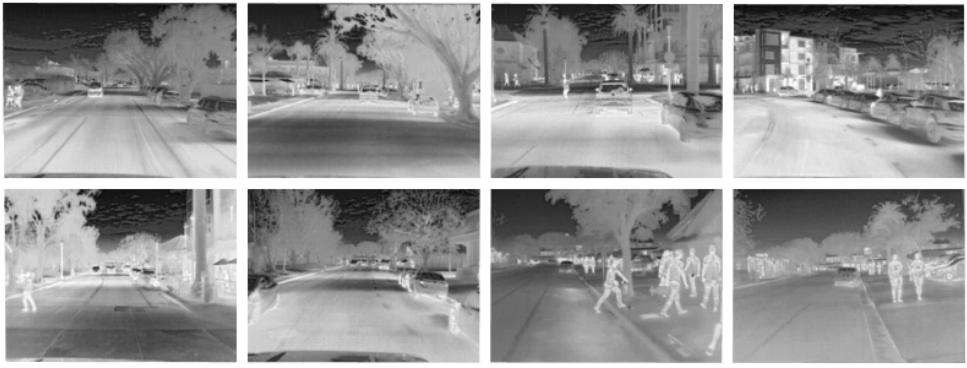
Figure 5. Examples of the Free FLIR Thermal Dataset for Algorithm Training